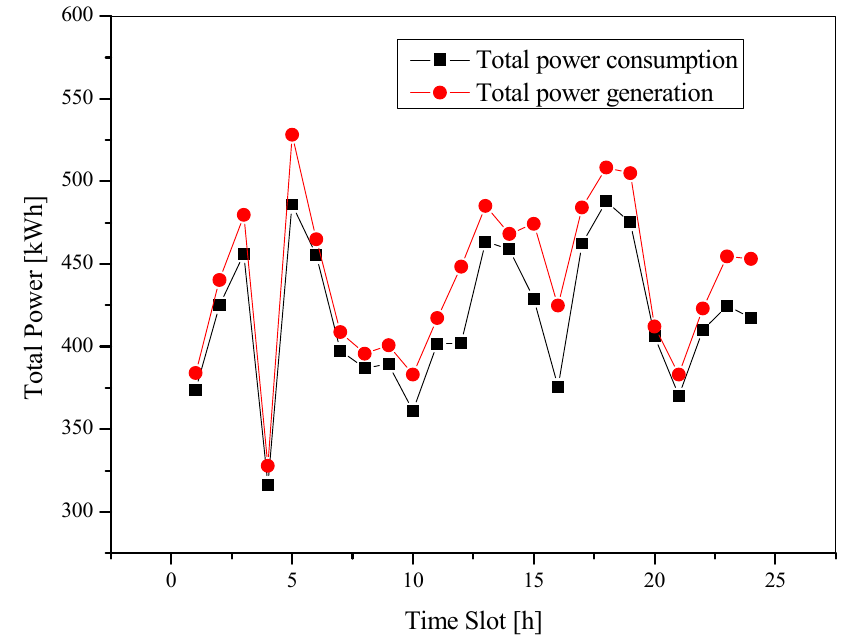
Figure 4. Total power consumption and generation.